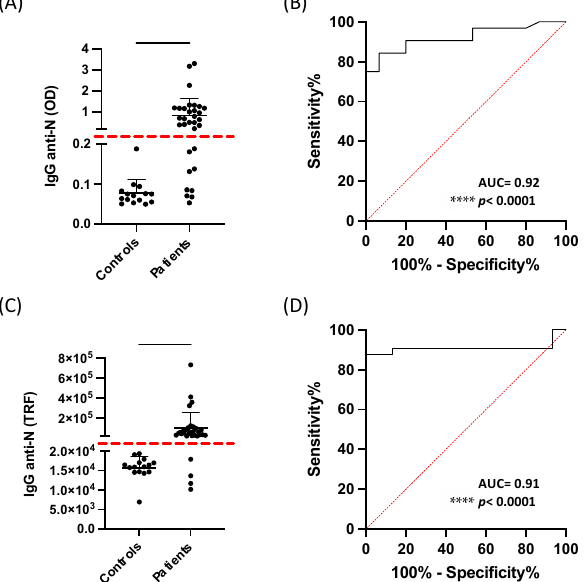
Figure 3. ELISA vs DBS-DELFIA performance analysis. ( A , C ) Scatter plots and ( B , D ) receiver operating characteristic (ROC) curves for SARS-CoV-2 nucleocapsid antibody detection by ELISA and DBS-DELFIA, respectively. IgG anti-N concentration in each subject. The plots show mean ± standard deviation. ROC curves indicate the area under the curve (AUC). **** p < 0.0001.